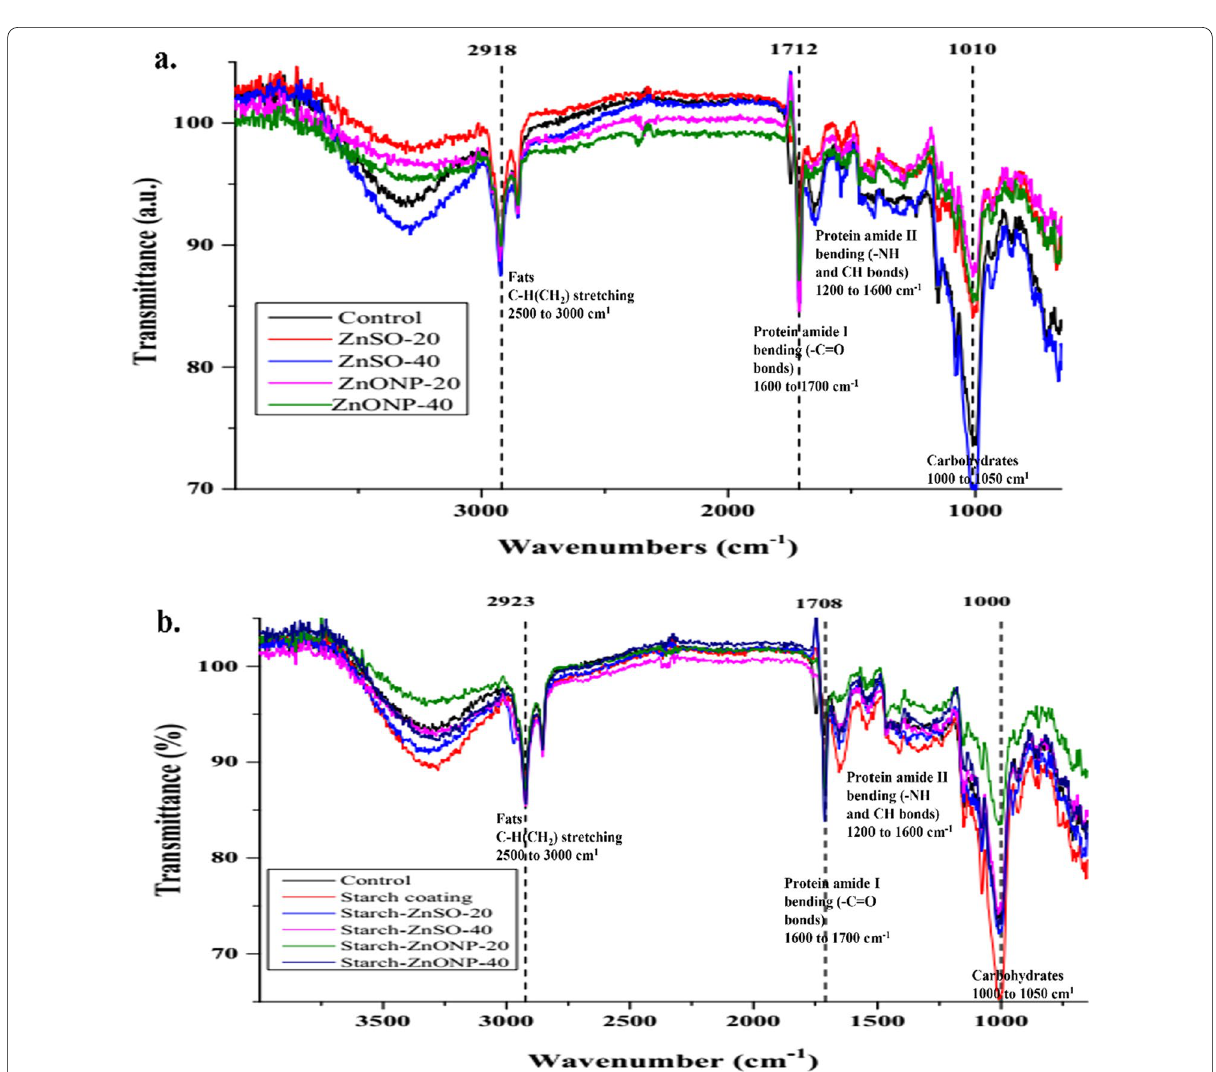
Fig. 3 Fourier‑transform infrared spectra of the maize flour depicting the effect of zinc source seed priming ( a ) and coating b treatments on chemical functional group